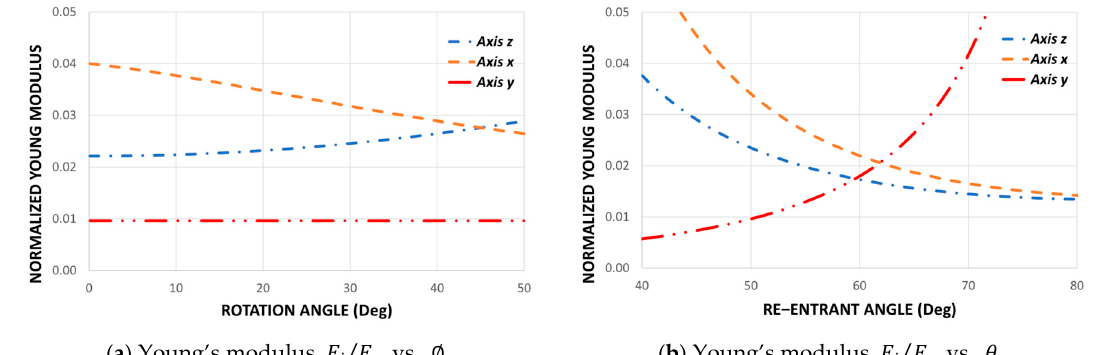
Figure 4. Normalized Young’s modulus E i / E s for different values of the re-entrant angle θ and for different values of the rotation angle ∅ . Considering H = 13.6 mm, L = 5.9 mm, t = 1.7 mm, θ = 50 ◦ and ∅ = ∅ 1 = ∅ 2 = 22.5 ◦